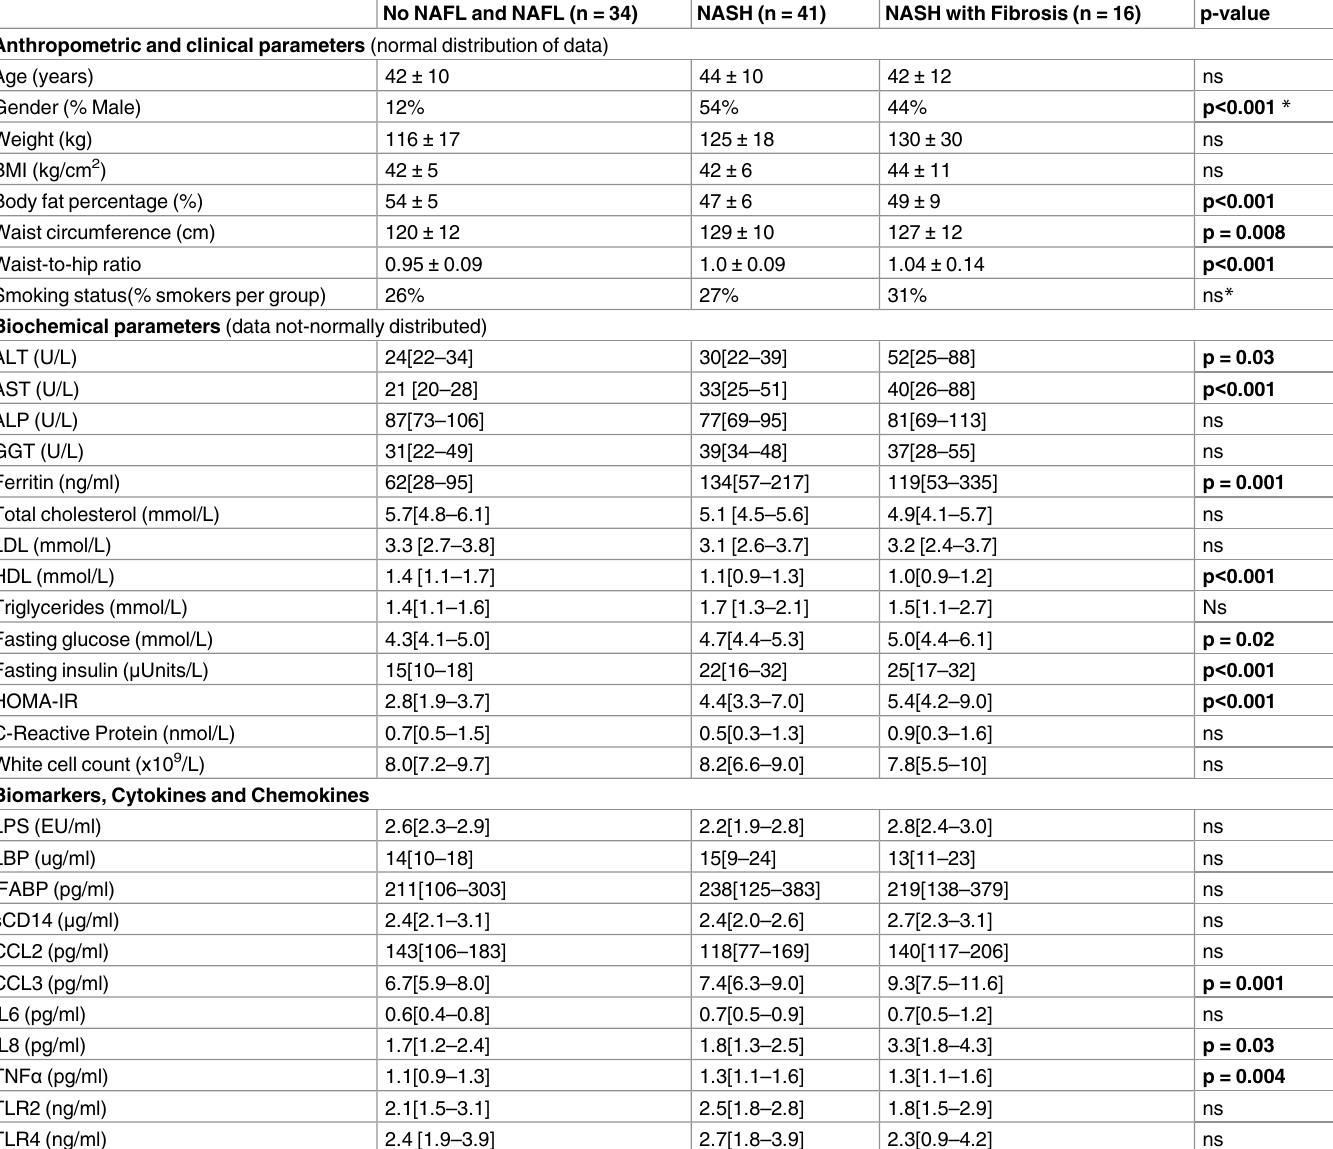
Table 1. Clinical and biochemical characteristics, plasma biomarkers, proinflammatory cytokines and chemokines measured in sub groups of patients with different stages of NAFLD. No NAFL and NAFL (n = 34) NASH (n = 41) NASH with Fibrosis (n = 16) p-value Anthropometric and clinical parameters (normal distribution of